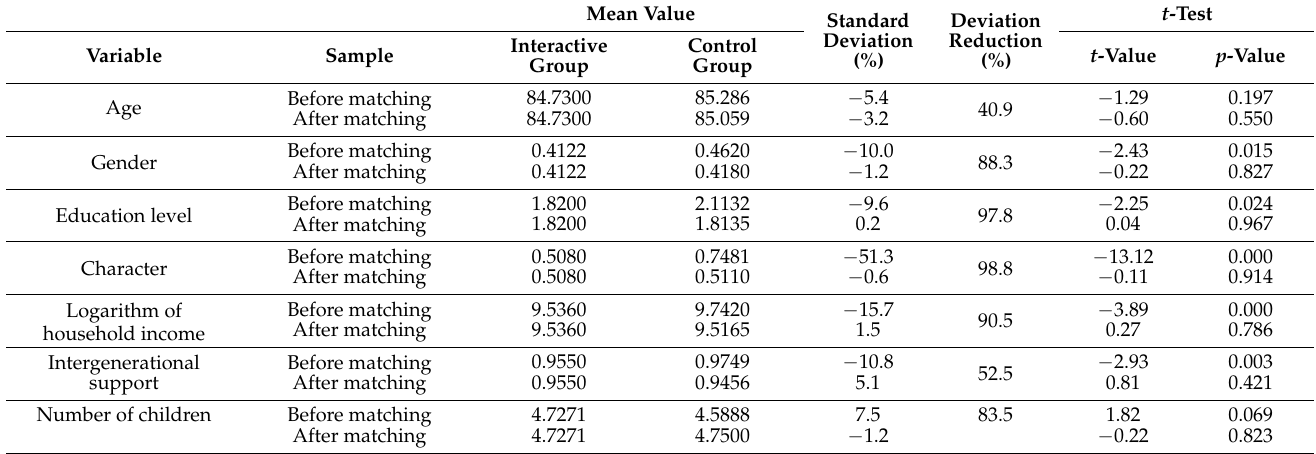
Table 6. Changes in characteristic variables before and after sample matching (neighbor).